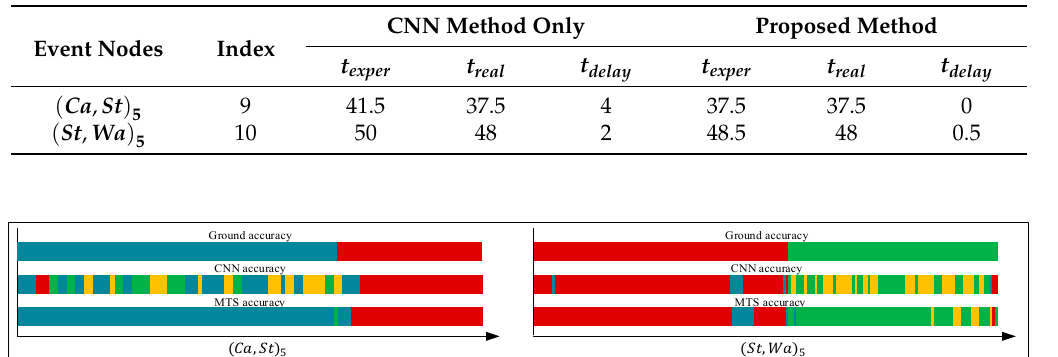
Figure 21. Graphs of < (cid:1829)(cid:1853), (cid:1849)(cid:1853) > (cid:2873) .